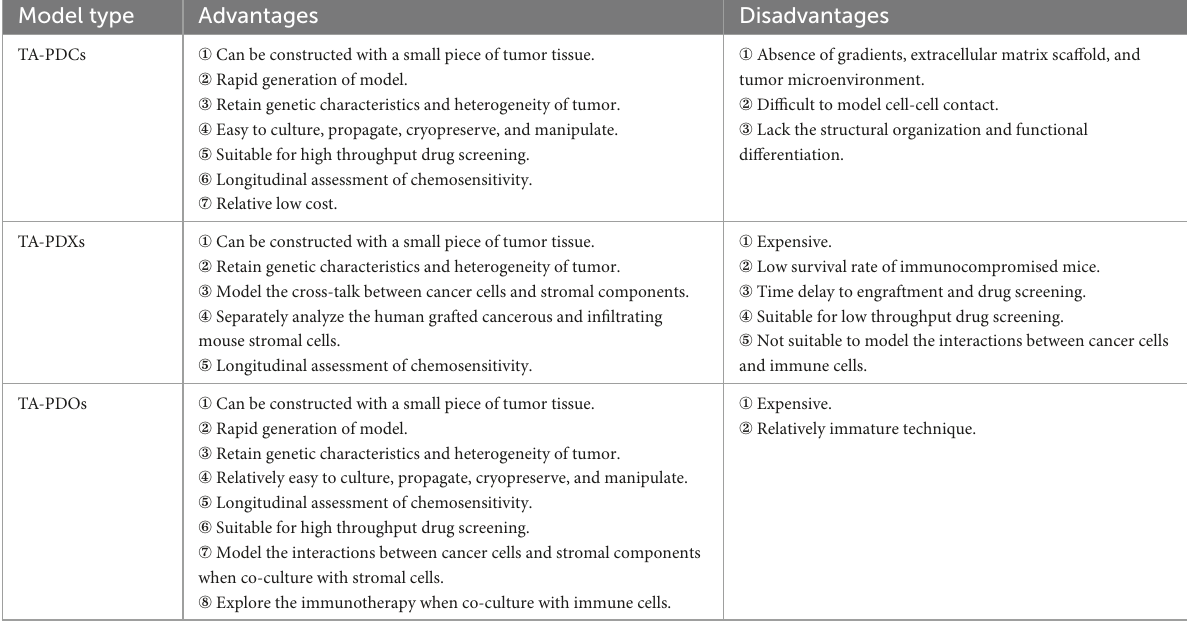
TABLE 3 The characteristics of preclinical models for human pancreatic ductal adenocarcinoma (PDAC) derived from endoscopic ultrasound-guided tissue acquisition (EUS-TA). Model type Advantages Disadvantages